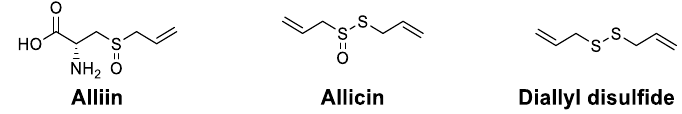
Figure 15. Structures of organosulfur compounds.